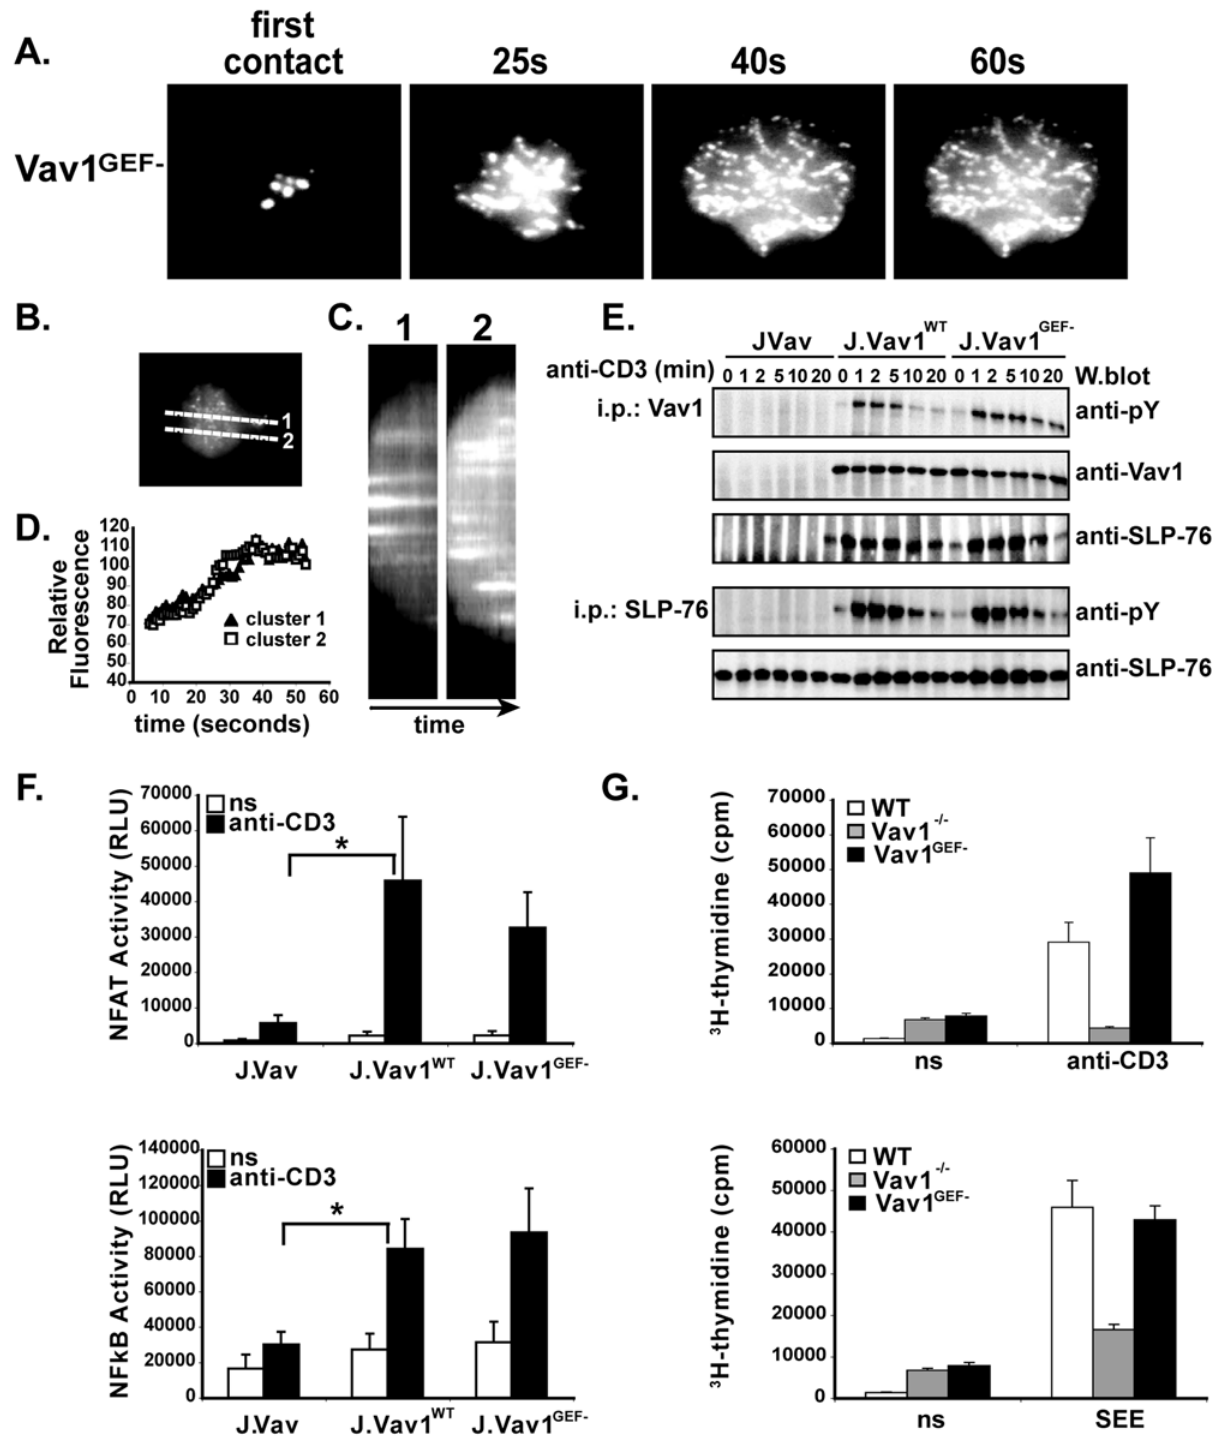
Figure 3. Vav1 GEF 2 forms microclusters and supports TCR-induced transcription and proliferation. (A) J.Vav1 GEF 2 cells were plated on anti-CD3-coated coverslips. Images were obtained in real time using TIRFM (times, above images). (B) Diagonal lines indicate sections of a representative J.Vav1 GEF 2 cell used for kymographic analysis. (C) Fluorescence of individual Vav1 GEF 2 microclusters over time (60s) is presented as horizontal ‘‘streaks’’ in kymographs for sections shown in (B). (D) Mean fluorescence intensity over time of individual Vav1 GEF 2 clusters, shown are representative images of n=5. (E) Tyrosine phosphorylation of Vav1 or SLP-76 immunoprecipitated from anti-CD3-stimulated J.Vav1 WT and J.Vav1 GEF 2 cells, visualized by immunoblotting with anti-phospho-tyrosine antibodies. Binding of SLP-76 to Vav1, determined by reprobing blots with anti-SLP-76 antibodies. ns=non-stimulated. (F) NFAT or NF k B luciferase reporter assays of anti-CD3-activated J.Vav, J.Vav1 WT and J.Vav1 GEF 2 cells, data are mean 6 SD n . 5 experiments. (G) Proliferation of WT, Vav1 2 / 2 or GFP + Vav1 GEF 2 T cells generated by HSCC reconstitution, as indicated, measured at 48 hr by 3 H-thymidine incorporation, n=2. Asterisks (*) indicate p , 0.05.